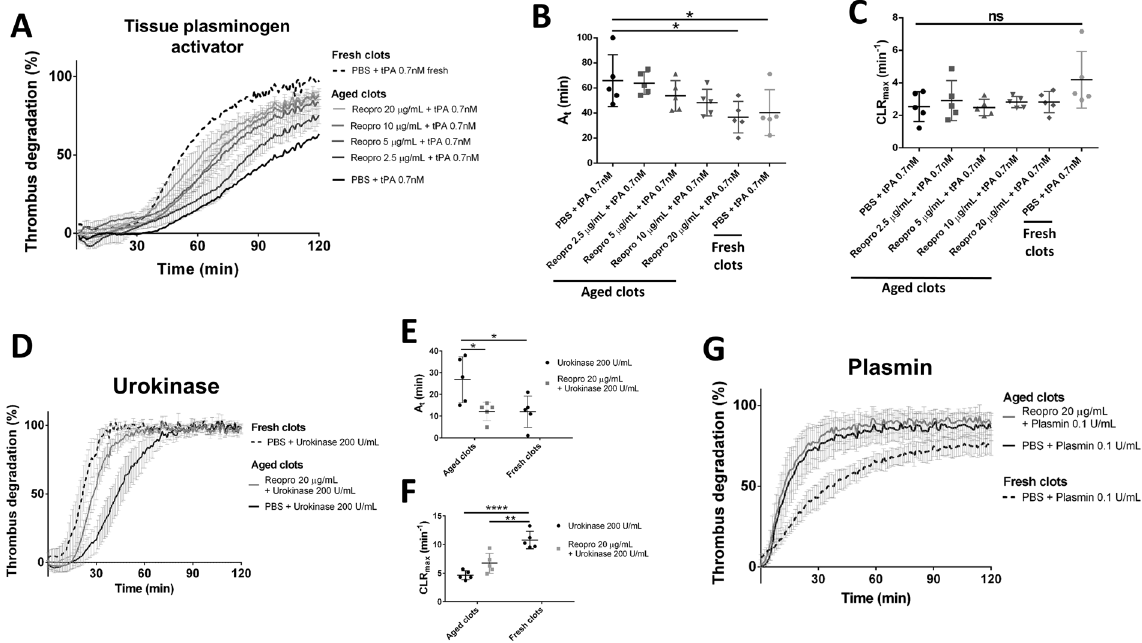
Figure 5. GPIIb/IIIa blockage reduces the thrombolysis resistance conferred by incubation time. Thrombolysis profiles with 0.7 nM tPA were measured on halo thrombi incubated for 4 hours (aged clots) with different concentration of GPIIb/IIIa blocker Reopro (0, 2.5, 5, 10 and 20 µ g/mL) and compared to thrombolysis obtained with 0.7 nM tPA on fresh clots ( A ). Activation times ( B ) and maximal clot lysis rates ( C ) were presented for each group as mean values ± SD (n = 5). Thrombolysis profiles with 20 U/mL urokinase ( D ) and with 0.1 U/mL plasmin ( G ) on halo thrombi incubated for 4 hours (aged clots) with or without 20 µ g/mL GPIIb/IIIa blocker Reopro and compared to thrombolysis obtained with 20 U/mL urokinase or 0.1 U/mL plasmin respectively. Activation times ( E ) and maximal clot lysis rates ( F ) were presented for the urokinase groups as mean values ± SD (n = 5). ns: not significant, * p < 0.05, ** p < 0.01, **** p <